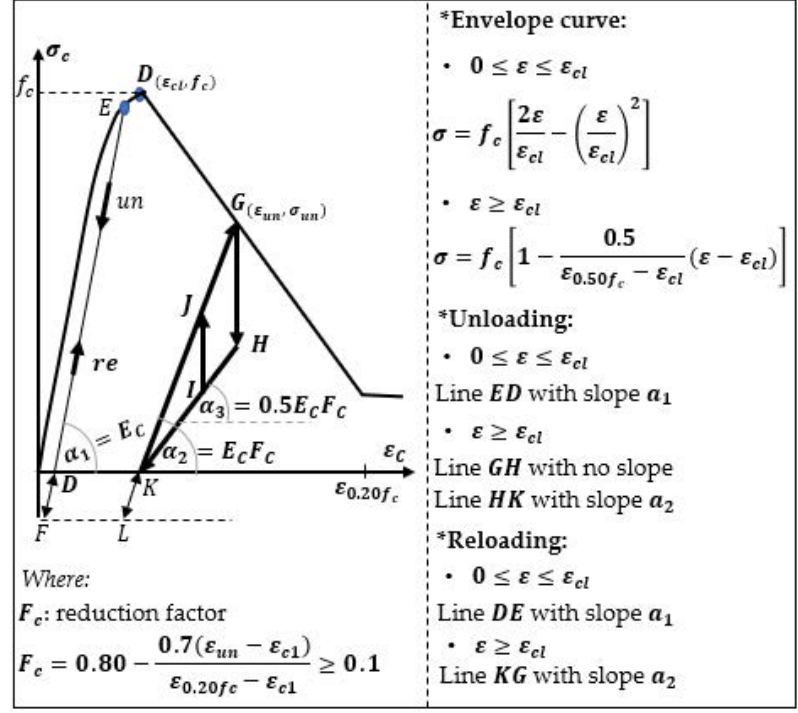
Figure 3. Concrete model according Blakeley and Park